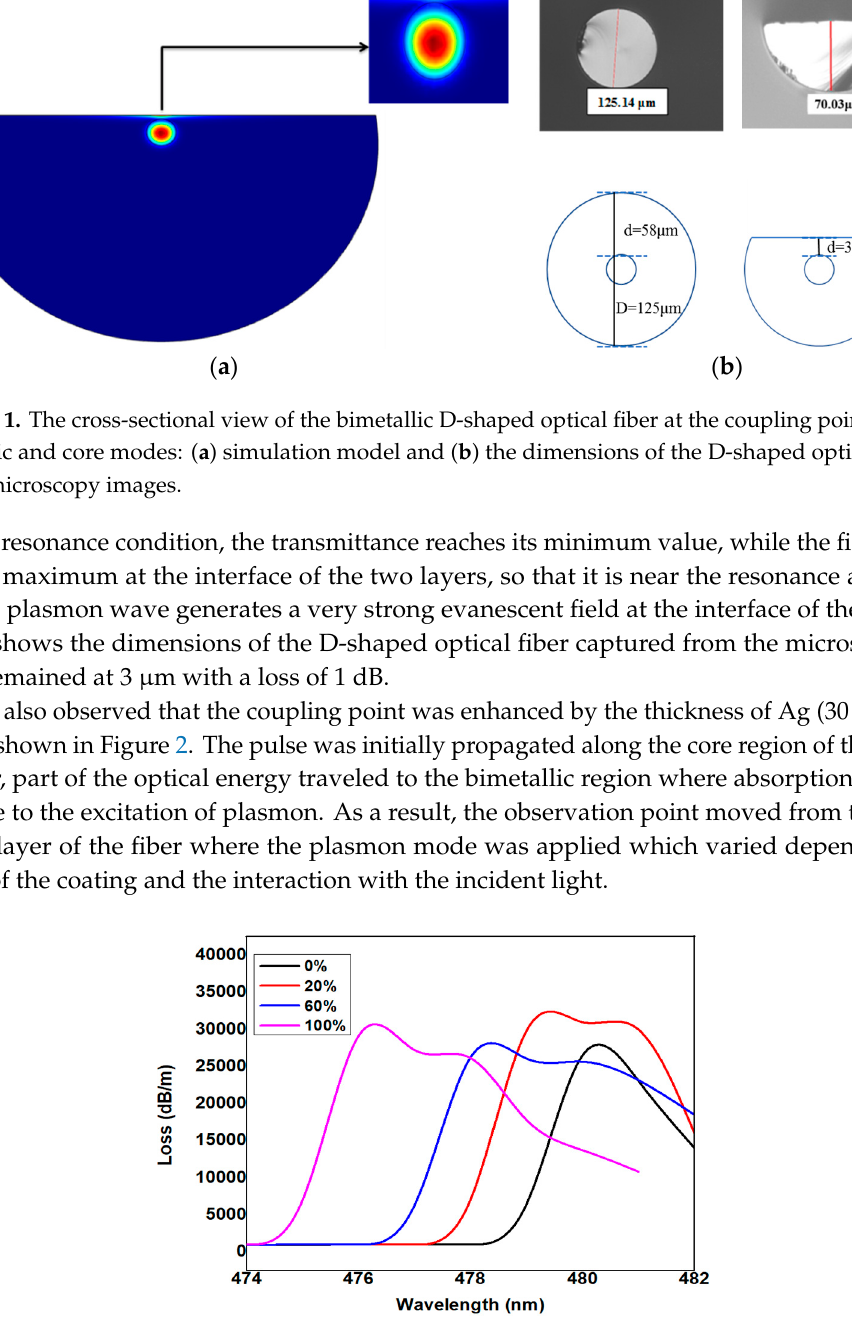
Figure 2. Loss spectra versus wavelength with respect to the variation of the alcohol concentration keeping Ag as 30 nm.